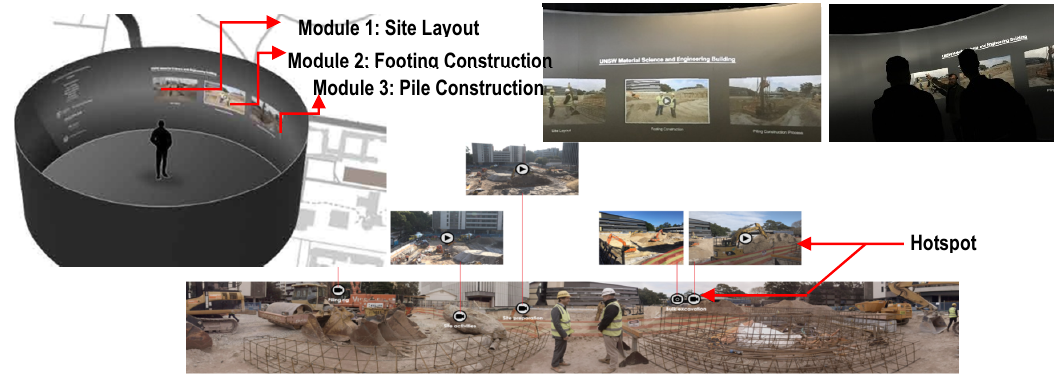
Figure 9. Three modules, including hotspots in the cylindrical theatre (VR Cinema). The construction site, including hotspots linked to 360 videos available to students.